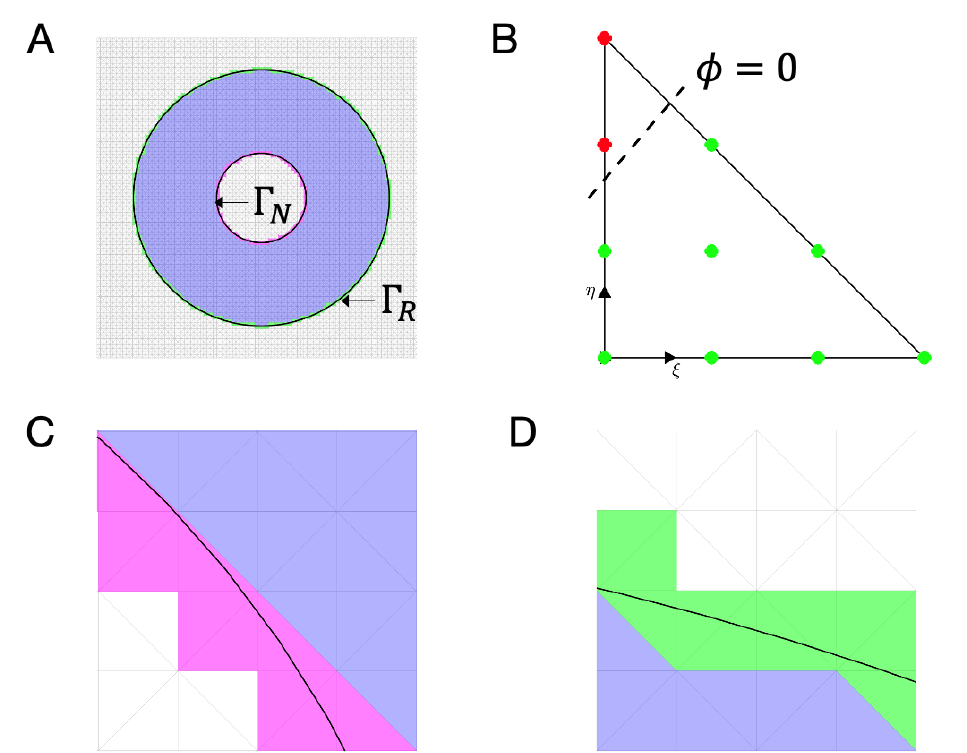
(cid:83) I Figure 4. ( A ) Elements T e for e ∈ I Ω (cid:83) I Γ , are colored in violet ( e ∈ I Ω ), magenta Γ R N ( e ∈ I Γ ), and cyan ( e ∈ I Γ ), being Γ N and Γ R the black lines. The square background domain Ω B N R (2.5 × 2.5 mm 2 ) is meshed with n p = 100 2 nodes and n e = 2 × 99 2 elements. Close-ups for